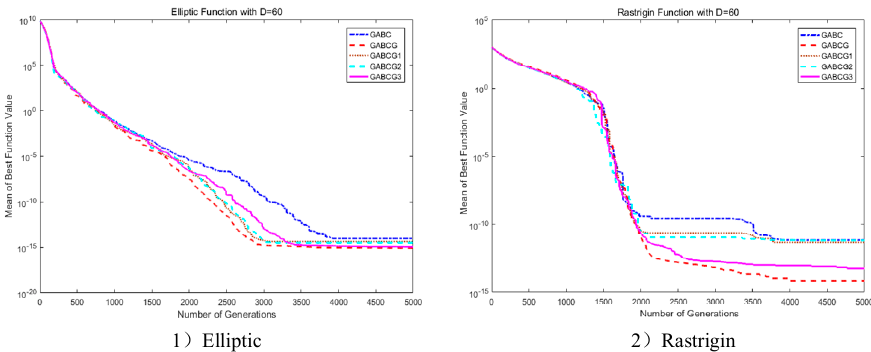
Figure 5. Convergence curves of different GABC algorithms for Rastrigin and Griewank functions.